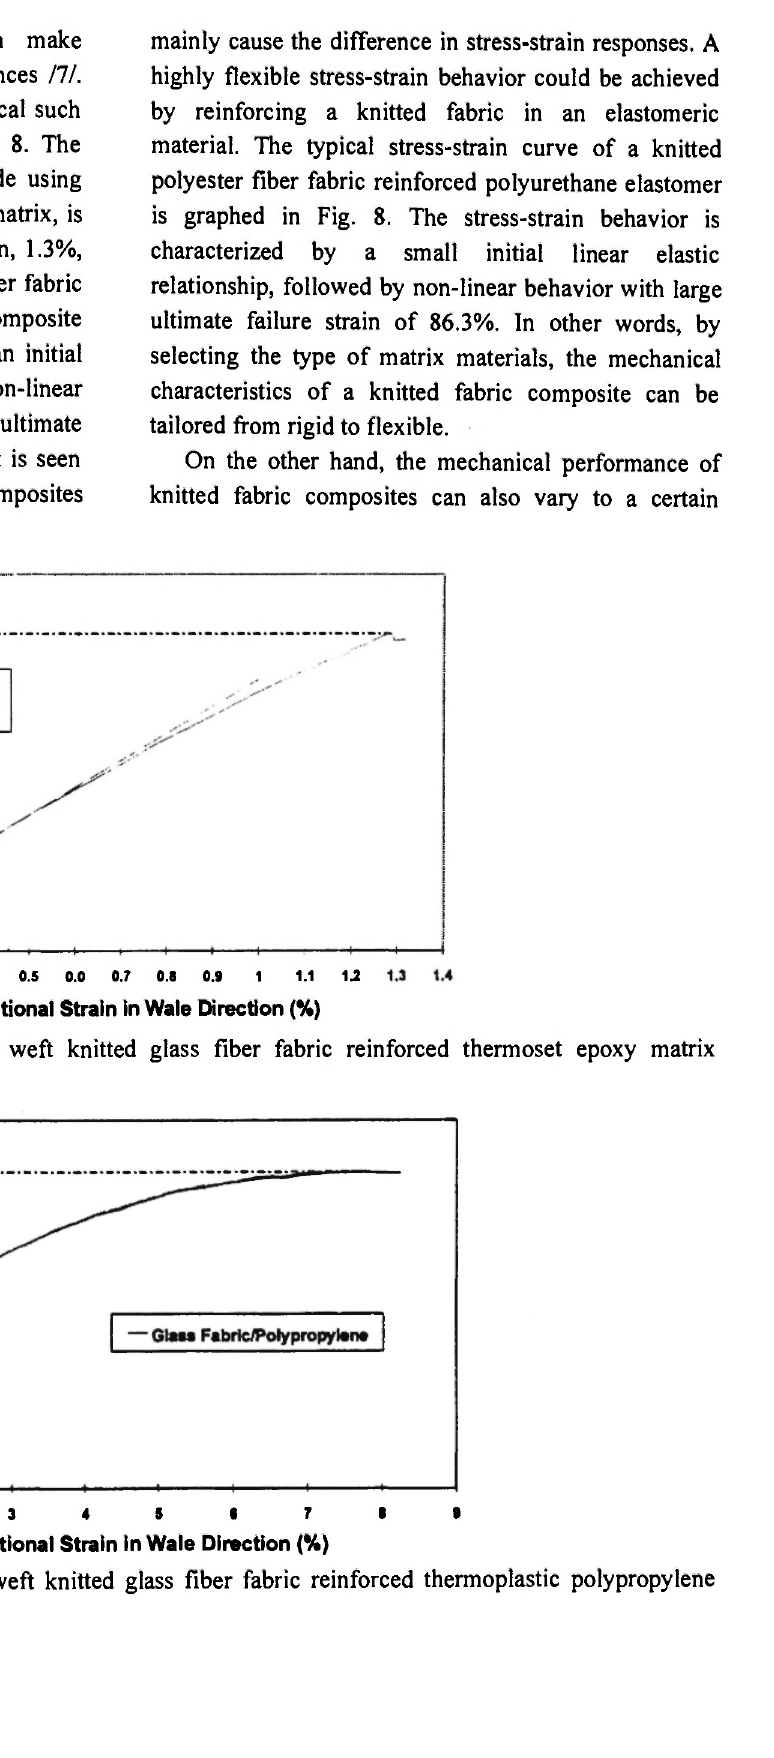
Fig. 7: Tensile stress-strain curve of a plain weft knitted glass fiber fabric reinforced thermoplastic polypropylene matrix